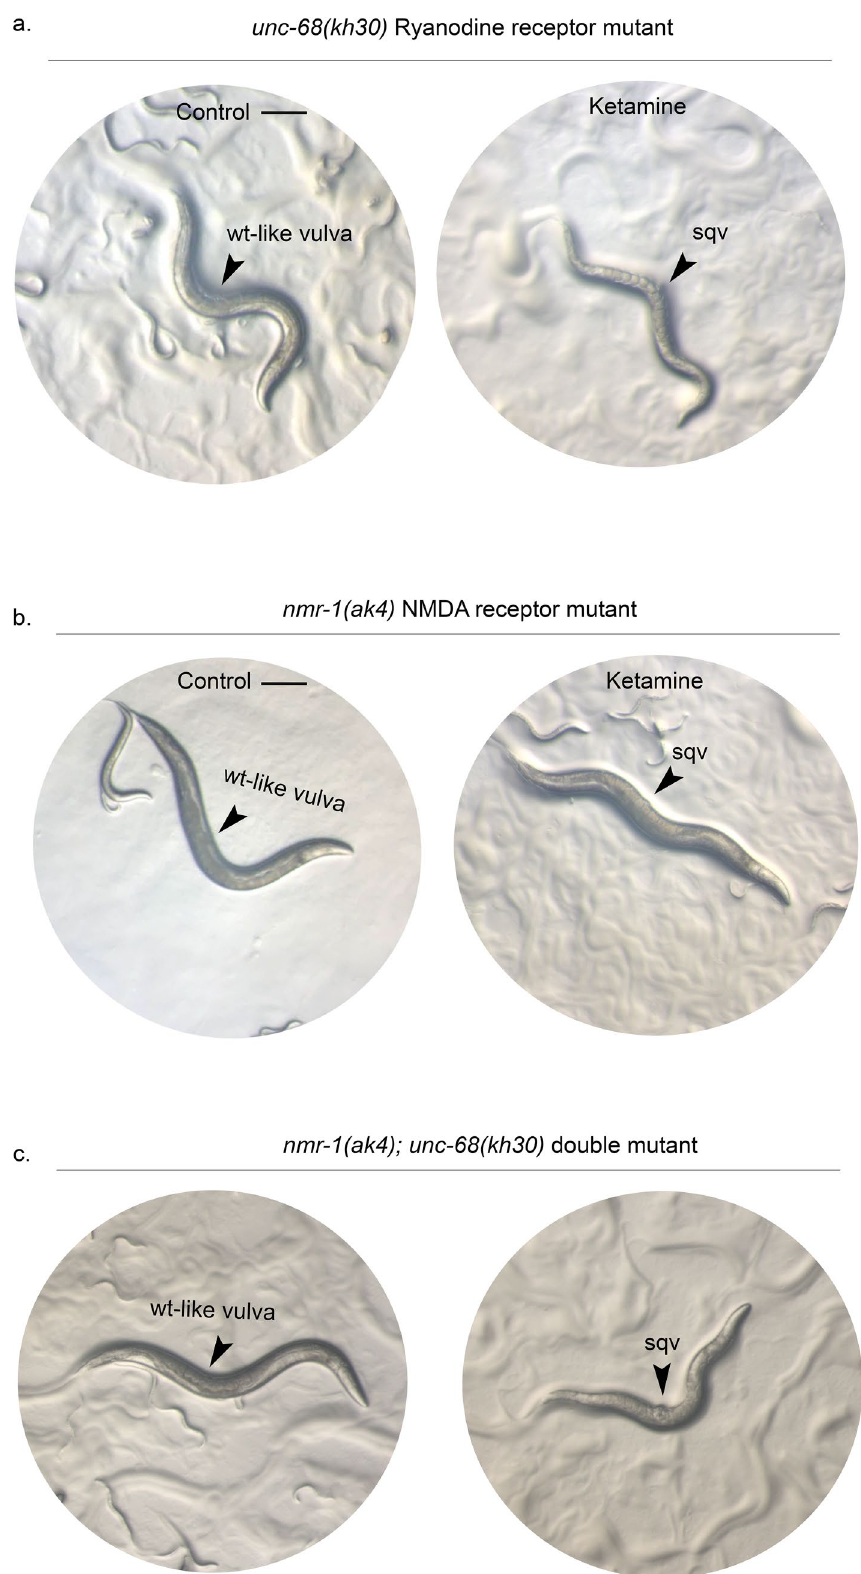
Figure 3. Ketamine receptor mutants display sqv phenotype ( a ) Worms carrying a mutation in ryanodine receptor unc-68 (n = 84) or ( b ) in NMDA receptor nmr-1 (n = 95) both show vulval invagination defect (Sqv phenotype) when exposed to ketamine. ( c ) Double mutants (n = 76) showed a similar penetrance for Sqv phenotype as single mutants. Arrowheads indicate the vulva. Scale bar 200